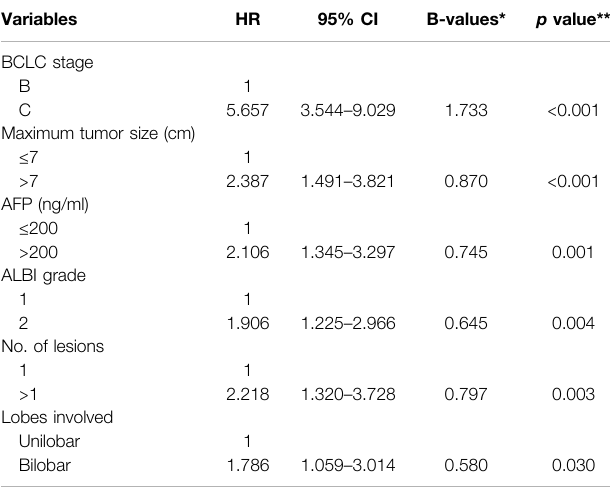
TABLE 3 | Multivariate analysis of risk factors associated with one-year disease control. Variables